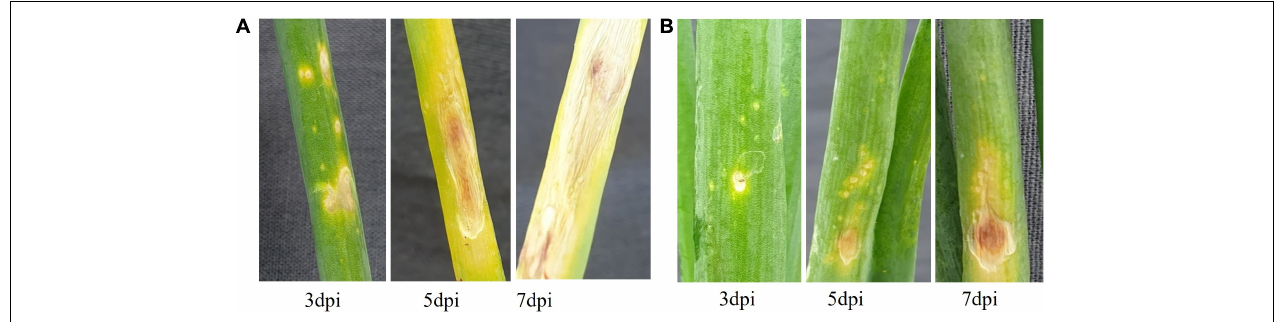
FIGURE 1 | Purple blotch (PB) symptom development in onion after pathogen inoculation; (A) Agrifound rose (AFR) and (B) Arka Kalyan (AK).